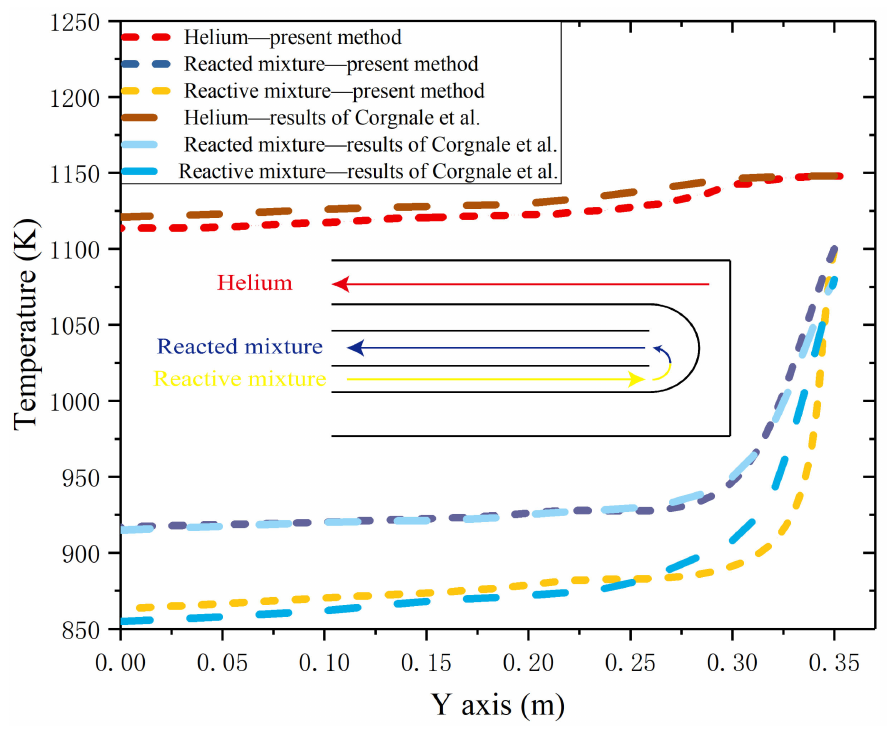
Figure 5. Numerical method verification of temperature field. Weight hourly space velocity (WHSV) is an important indicator used to measure the decomposition rate [38]. It is defined as the inlet sulfuric acid flow rate per unit of catalyst mass. An experiment on the wide range application of WHSV was implemented by Zhang et al. [27]. Table 3 shows the relevant experimental and simulation results of the